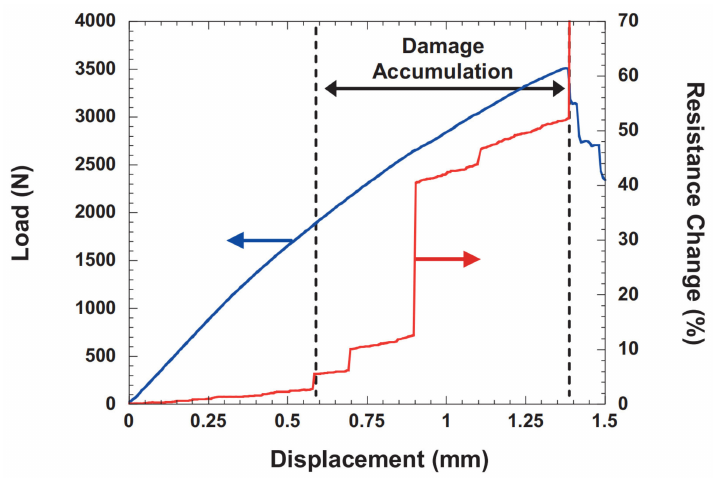
Figure 6. Load/displacement and resistance response of a (0/90) s cross-ply composite showing accumulation of damage due to micro-cracks